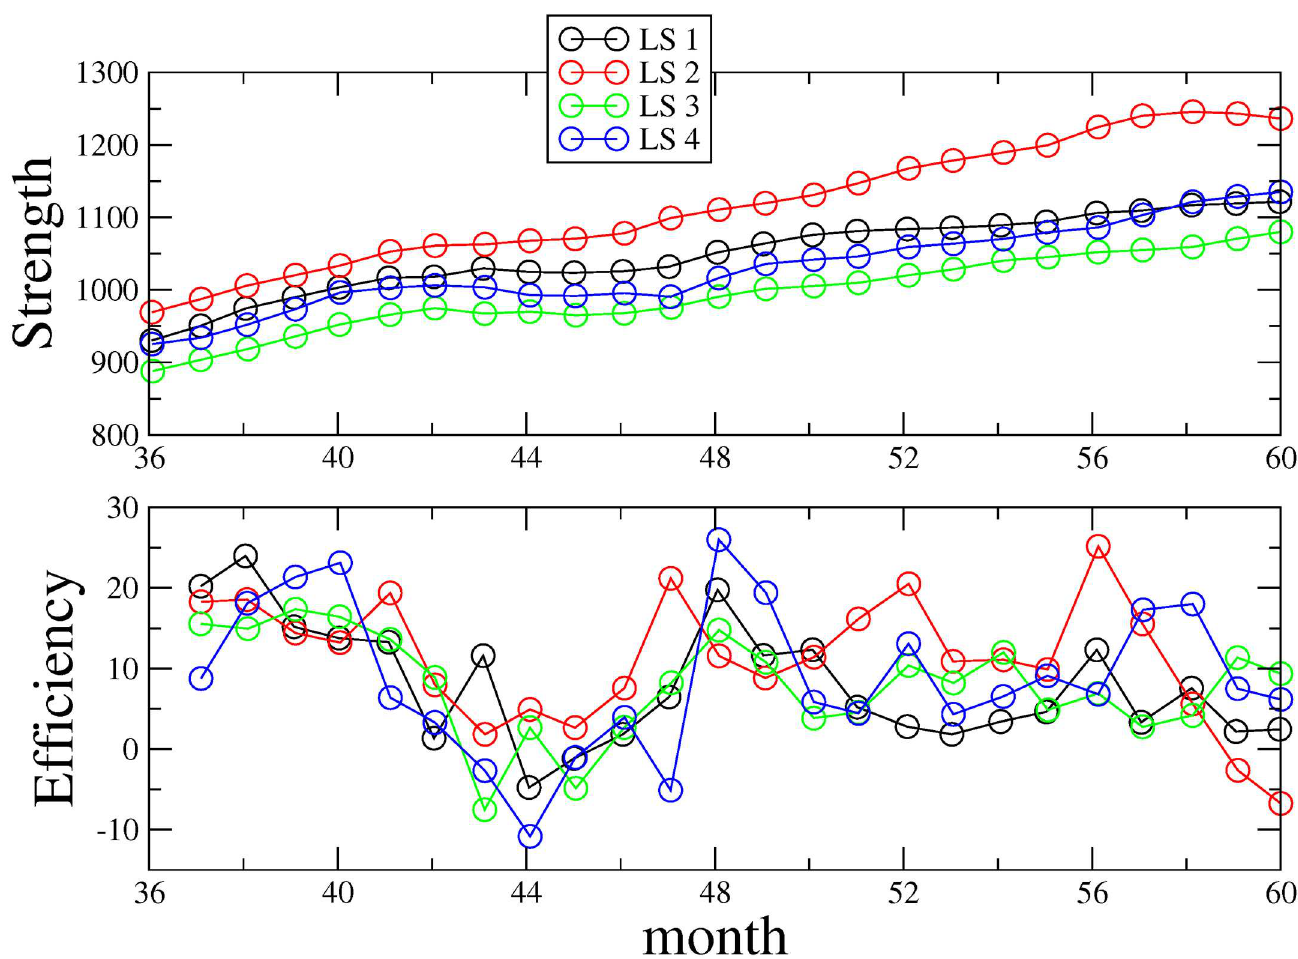
Fig 3. Strength and efficiency of leadership systemsacross time. Analysis of the complexity leadershipfunctions for each LS through a measure of (a) its strength F ( t ) (see Eq 3) and of (b) its efficiency E ( t ) (see Eq 4). Time is sampled in units of one month.